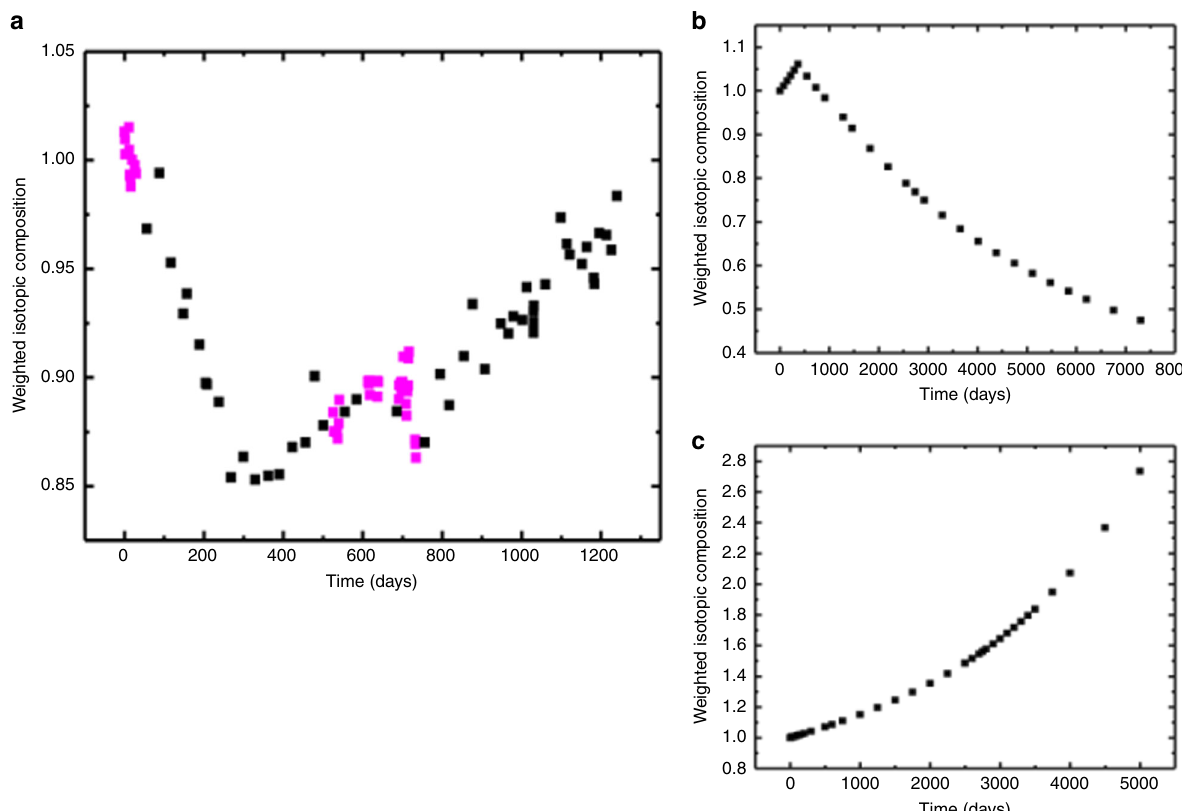
Fig. 3 Weighted isotopic composition of small modular reactor cores versus time. a Weighted isotopic composition of the NRU core versus time, based upon data from core-following software. Points in magenta indicate times for which neutron count rate data presented in this work was taken. b Weighted isotopic composition of a simulated 3021 kg 4% LEU molten salt reactor core, versus time 14 . c Weighted isotopic composition of a simulated 956 kg 19.8% LEU high-temperature gas-cooled reactor core, versus time 14